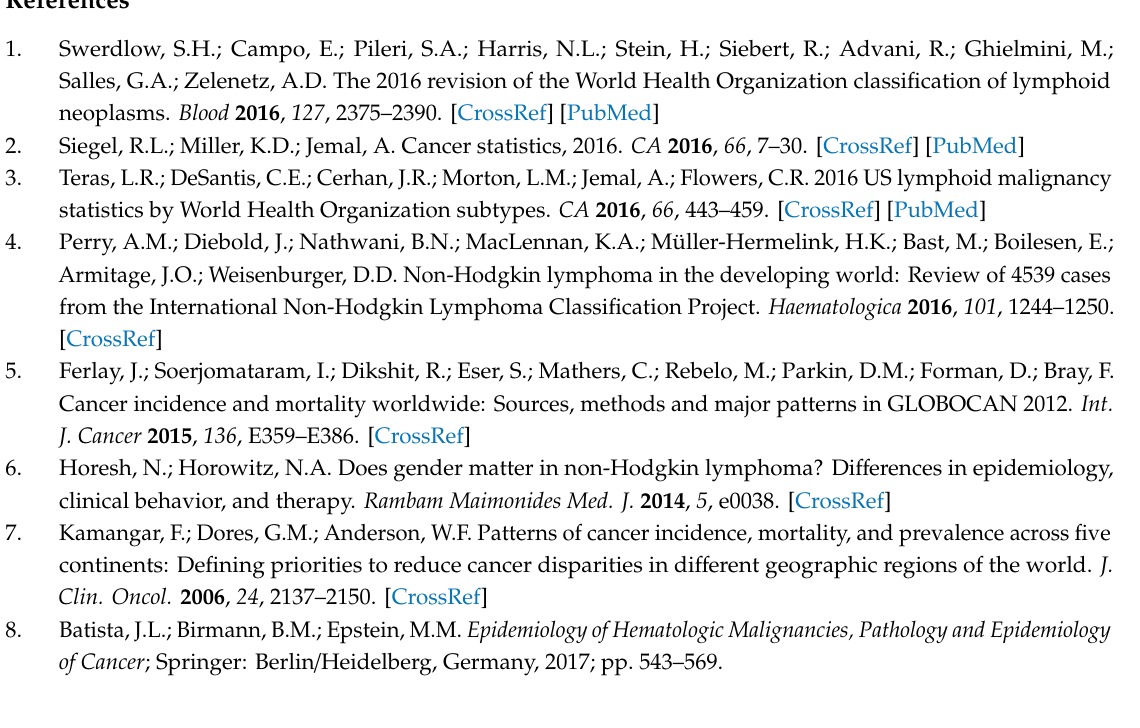
Table S1: The Hardy–Weinberg equilibrium (HWE) p -values for the cases and the controls. Table S2: The Frequency of allele and genotype for seven cytokines related SNPs in DLBCL patients and controls (Case / Control). Table S3: Genotype distribution of the IL-6 and IL-10 in DLBCL patients. Table S4: Multivariate Survival analyses using Cox Regression Model for SNP 1800797 and controlling for Age and Stage. S1: Dataset. S2: Survival analysis. Author Contributions: Conceptualization and design, S.M.A.-K., N.A. and L.N.A.-E.; data collection, A.-H.A.-M., D.J.Z. and T.Z.K.; data analysis and interpretation, N.A., S.M.A.-K.; manuscript writing, S.M.A.-K. All